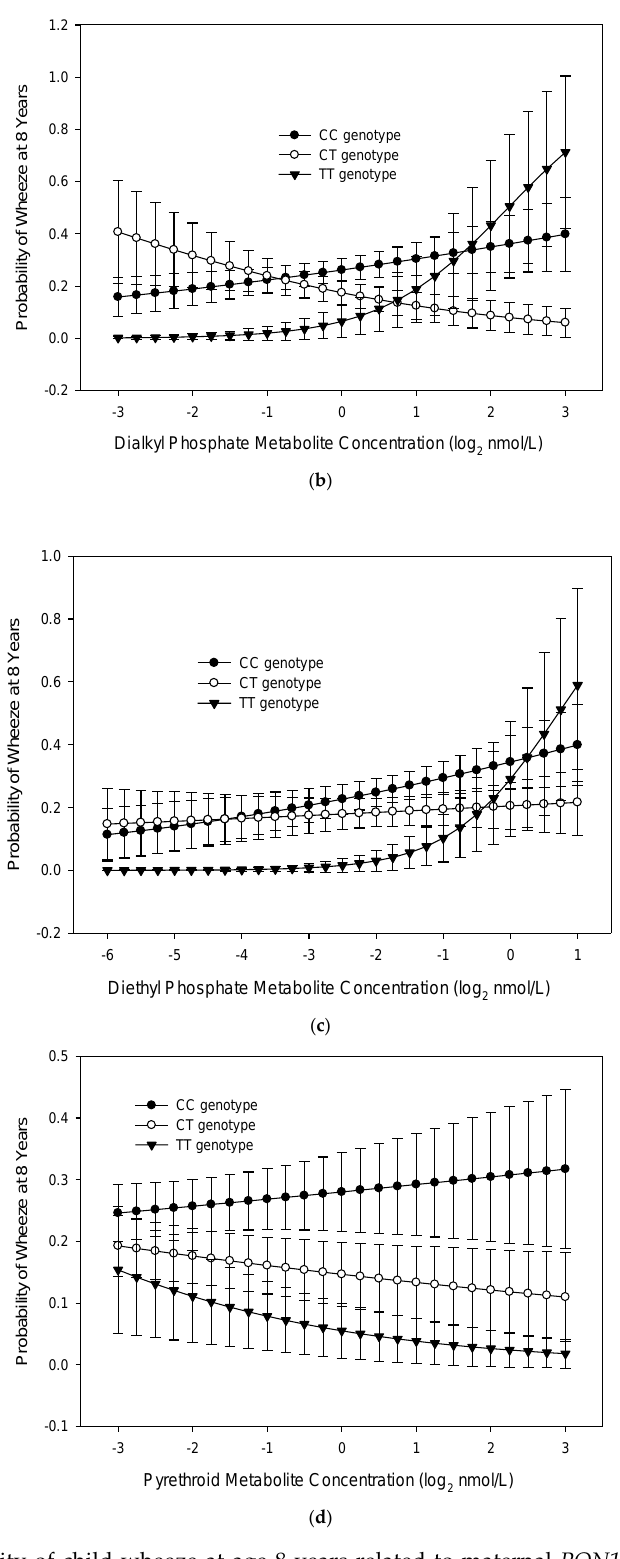
Figure 2. Probability of child wheeze at age 8 years related to maternal PON1 −108 genotype and ( a ) dimethyl phosphate (DM) metabolite concentration, ( b ) dialkyl phosphate (DAP) metabolite concentration, ( c ) diethyl phosphate (DE) concentration, and ( d ) pyrethroid (3-Phenoxybenzoic acid, 3PBA) metabolite concentration during gestation ( n = 224).